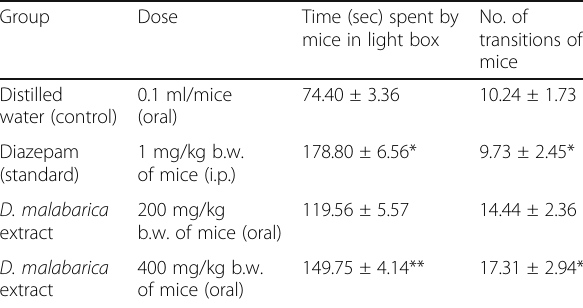
Table 2 Effect of D. malabarica extract in LDT test Table 3 Effect of the ethyl acetate extract of D. malabarica